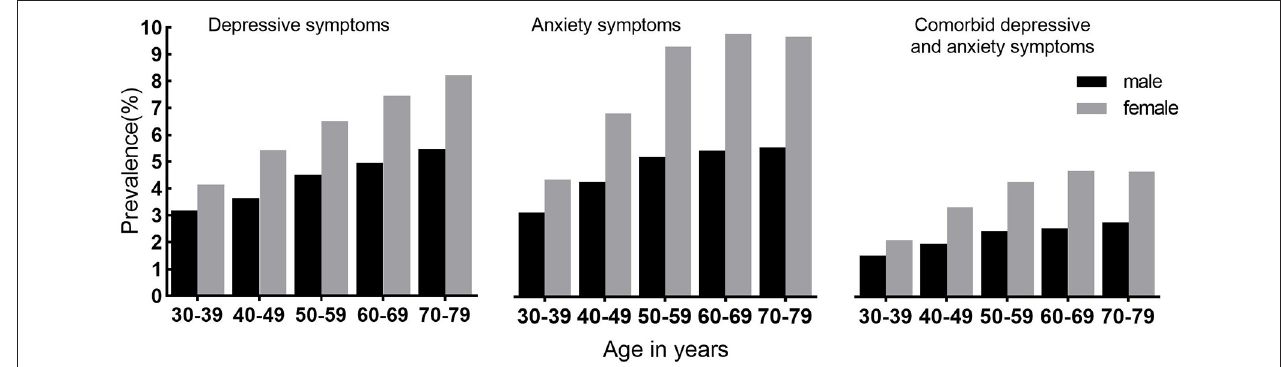
FIGURE 1 | Prevalence of depressive symptoms and anxiety symptoms and comorbidity by age and sex.